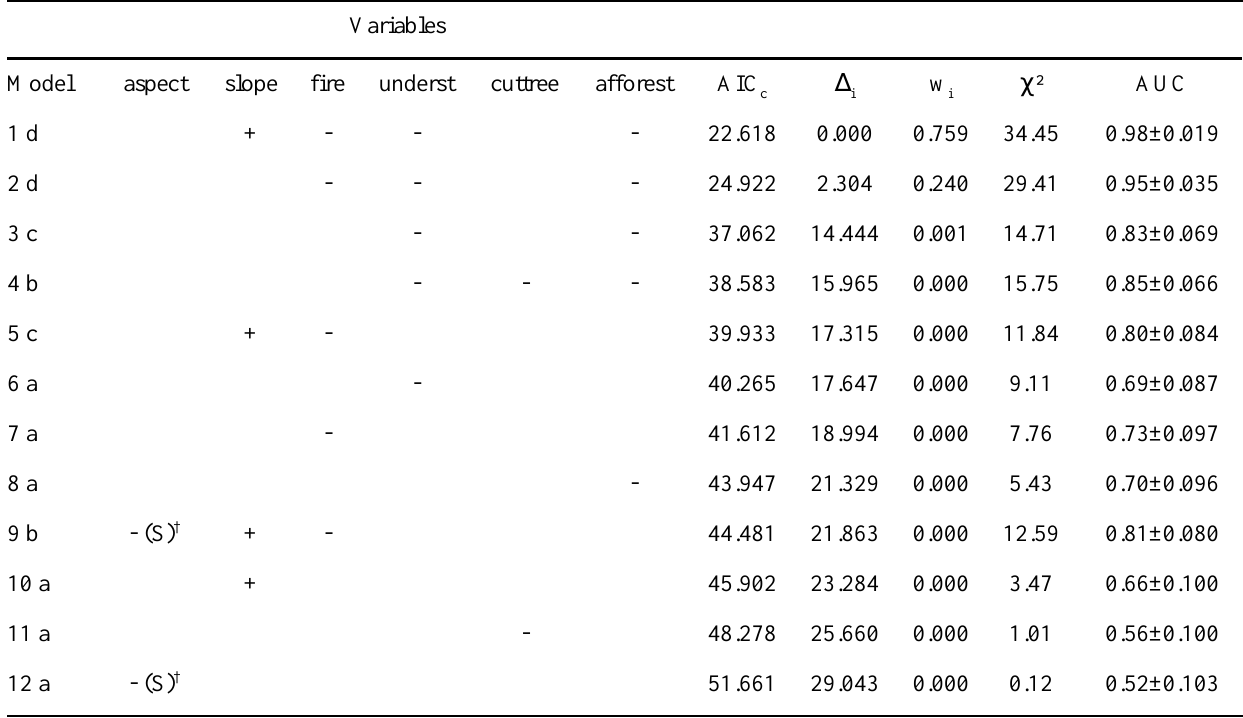
Table 5. Statistical models for tree persistence. For each model, the table shows the predictor variables entering the model (remaining variables did not enter), respective direction of association (positive + or negative -) with the response variable (presence of cork oak persistence), the AICc value, AICc differences ( D i) and Akaike weights (wi), and model fit (full model c ²) and area under curve (AUC±s.e.). Models are ordered by increasing D i, with the best model having D i=0 (model 1) and the worst model having D i=29.0 (model 12). The type of model is also coded according to the method used: (a) separate models for each variable, (b) models for each set of biophysical and management variables, (c) stepwise models for each set of biophysical and management variables, (d) stepwise models with the whole set of variables. Codes for management variables: underst= understory management pre 1975; cuttree= tree cutting post 1975; afforest= tree planting post